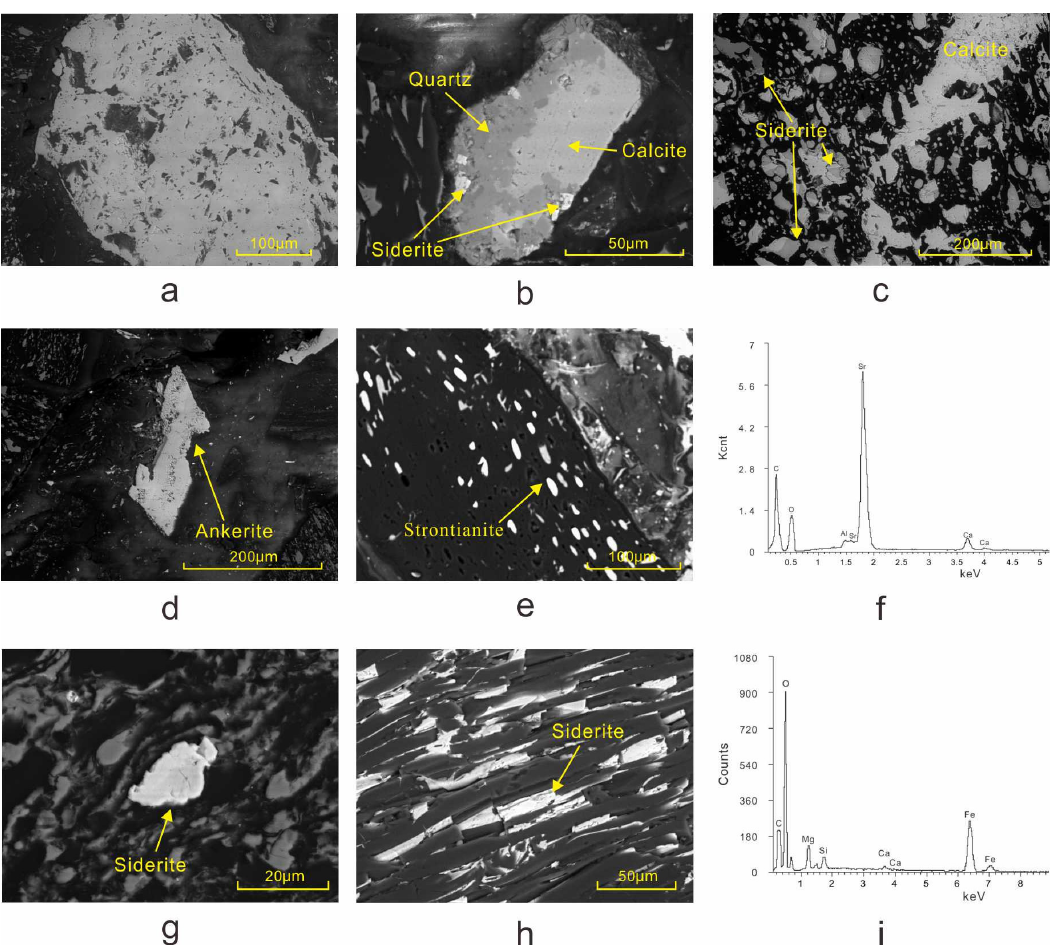
Figure 5. SEM back-scattered electron images of carbonate minerals in the coals of Huainan coalfield. ( a ) Authigenic calcite occurring as pore infillings, S2, P1 mine, No. 13-1 coal seam; ( b ) preexisting quartz replaced partly by calcite, S2, P1 mine, No. 13-1 coal seam; ( c ) intergrown ankerite and calcite, S6, Wangfenggang (WFG) mine, No. 13-1 coal seam; ( d ) ankerite occurring as pore infillings, S2, P1 mine, No. 13-1 coal seam; ( e ) strontianite occurring as pore infillings, S18, P1 mine, No. 1 coal seam; ( f ) X-ray EDS spectrum of strontianite in panel ( e ); ( g ) siderite as ellipsoidal nodules surrounded by deformed maceral and clay layers, S2, P1 mine, No. 13-1 coal seam; ( h ) siderite occurring as compressed cell infillings, S6, WFG mine, No. 13-1 coal seam; and ( i ) X-ray EDS spectrum of siderite in panel ( h ).